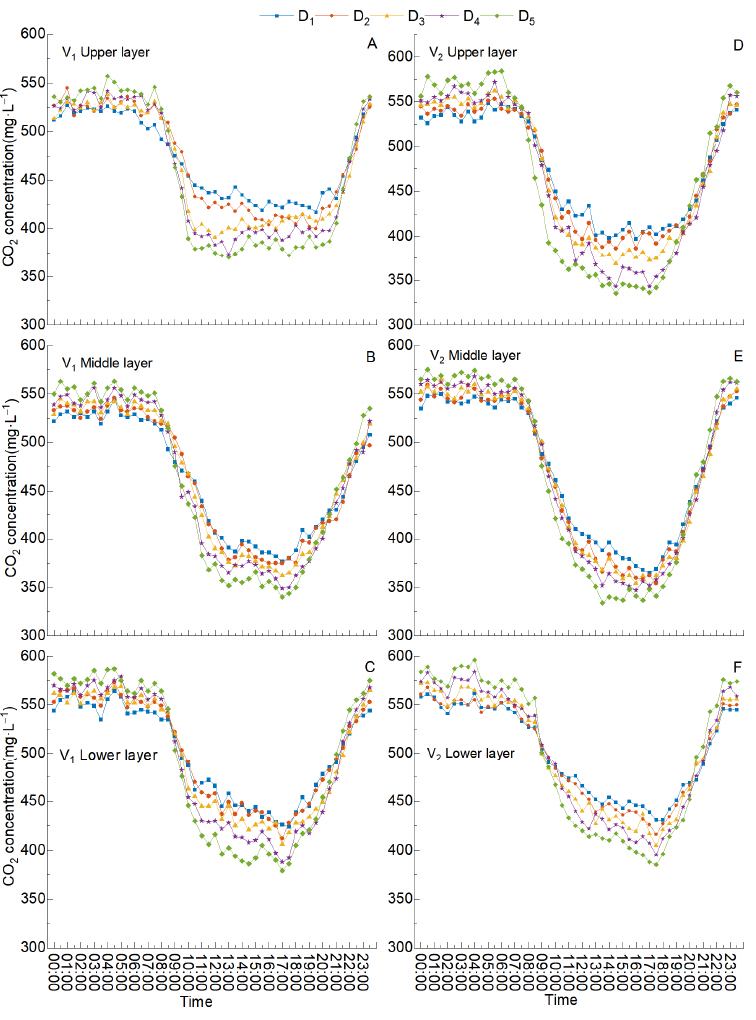
Figure 7. Effects of planting density on canopy CO 2 concentrations in uniformly sown winter wheat. V 1 , Xindong 50. V 2 , Sangtamu 4. ( A – C ) refer to the upper, middle, and lower layers of Xindong 50, respectively, whereas ( D – F ) refer to the upper, middle, and lower layers of Sangtamu 4,